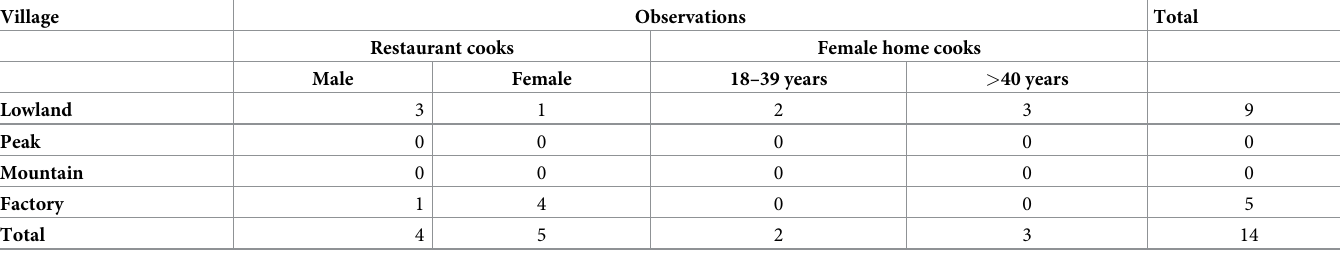
Table 3. Overview of number of observations of cooking sessions involving pork preparation. Village